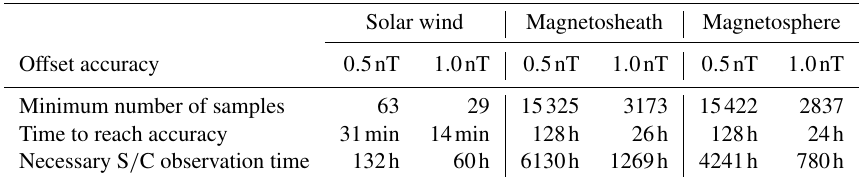
Table 4. Minimum number of O z,n estimates (first row) and corresponding time ranges (second row) required to determine the offset with an accuracy of 0 . 5nT or 1 . 0nT in the solar wind, magnetosheath, or magnetosphere. The necessary observation time of the spacecraft (third row) in each